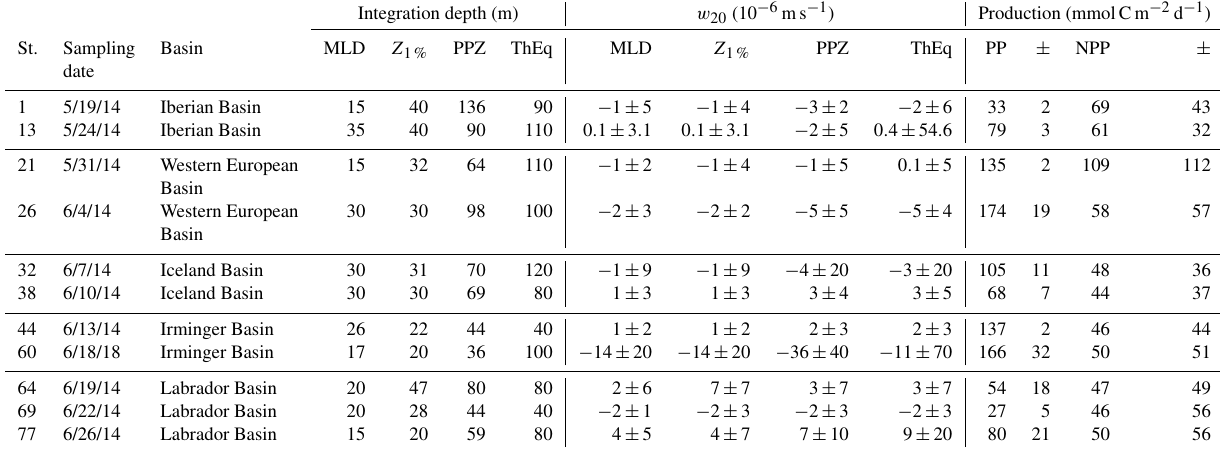
Table 1. The mixed-layer depth (MLD, defined as a change in potential density of 0.03kgm − 3 relative to the potential density at 10m), the depth of the euphotic zone ( Z 1% , defined as the depth at which photosynthetic available radiation was 1% of its surface value), the primary production zone (PPZ, at which the fluorescence reaches 10% of its maximum), and the 234 Th- 238 U equilibrium depth (ThEq) at each station along the GA01 transect. Together with the 30-day (30 days prior to the sampling date) average vertical velocity within the 20m under the corresponding depths ( w 20 , 10 − 6 ms − 1 , downwards as positive direction). Primary production (PP) and net primary production (NPP) rates derived from 24h bottle incubations (Fonseca-Batista et al., 2018; Lemaitre et al., 2018) and from the VGPM products, respectively, are also presented. Note that the NPP rates were averaged for the previous 138 days ( 210 Po half-life) prior to the sampling date. Dates are in mm/dd/yy